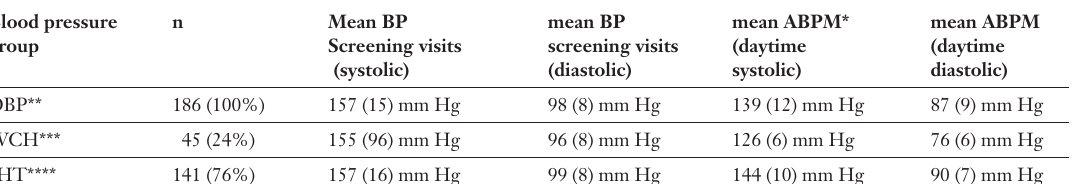
Blood pressure read- ings during screening visit and at time of 24-hour ambulatory blood pressure.